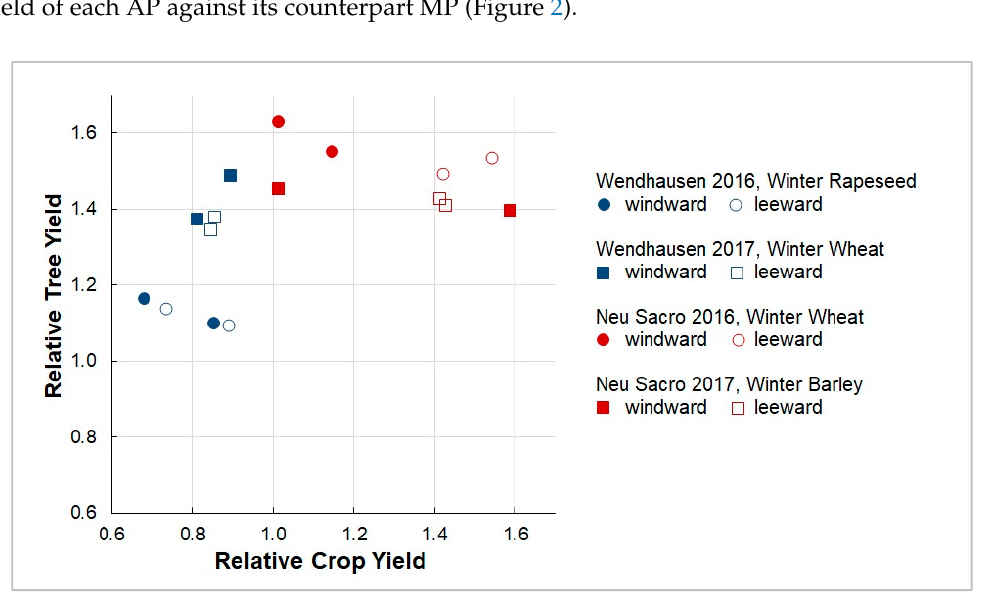
Figure 2. Relative tree and crop yields obtained from lee- and wind-ward arranged poplar strips with cropped alleys at Wendhausen and Neu Sacro, over the investigated years.